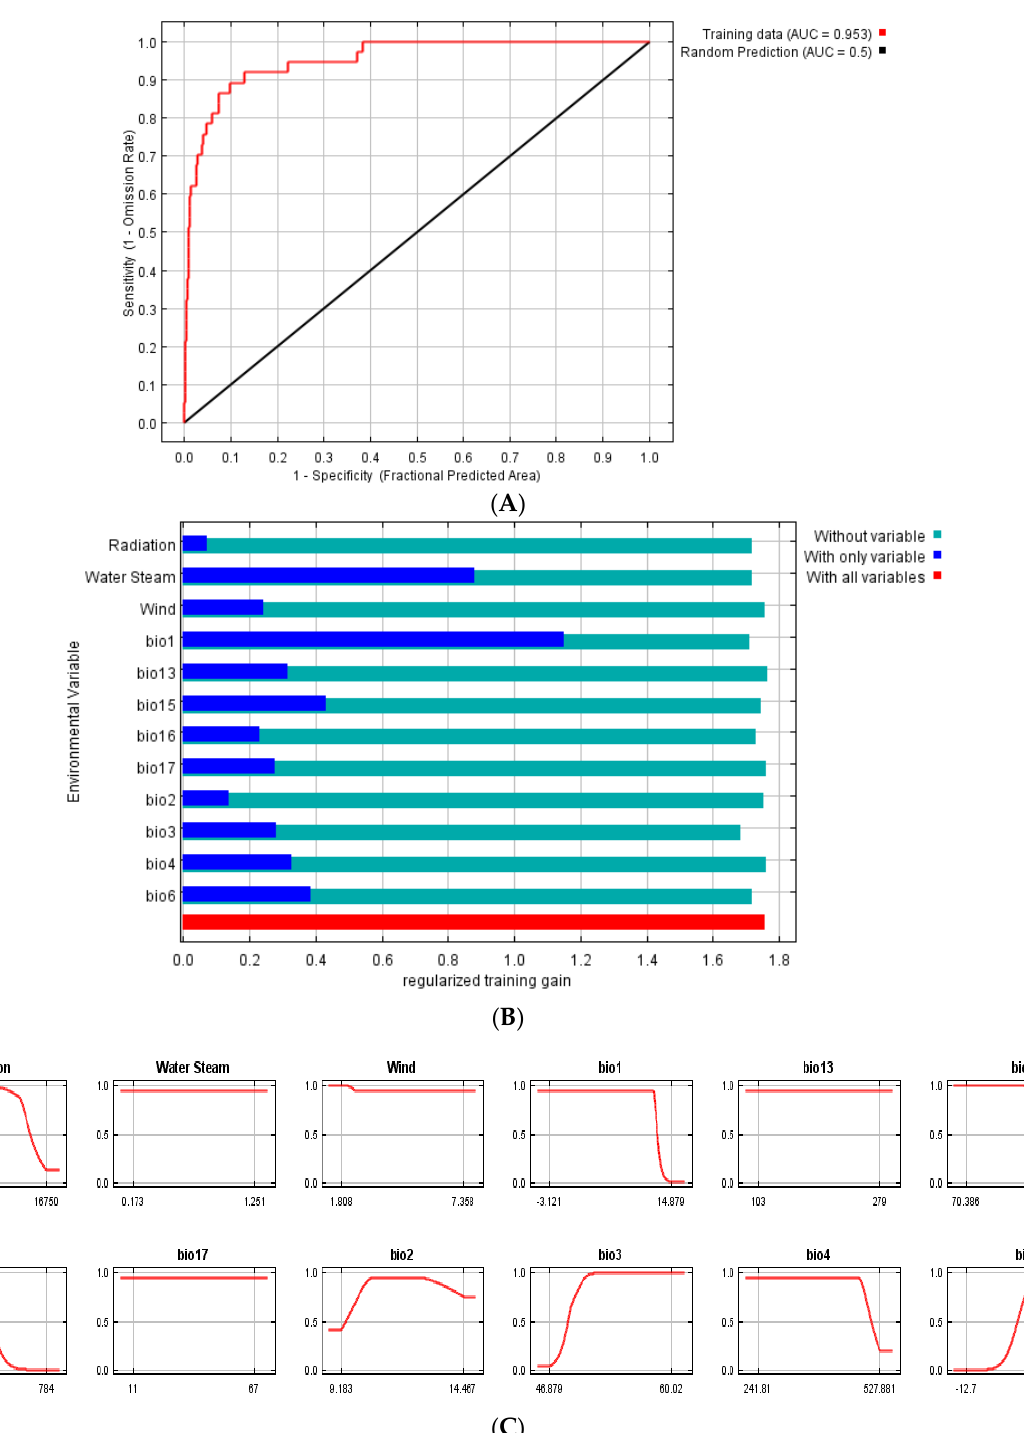
Figure 4. Maxent model current projection for G. avellana. ( A ) Analysis of omission/commission; pictured is the receiver operating characteristic (ROC) curve. ( B ) Picture shows the results of the permutation test of variable importance (for codes detail, see Table 2). ( C ) Response curves of G. Avellana to variables. Table 2. Permutation importance of variables for the Maxent Model.